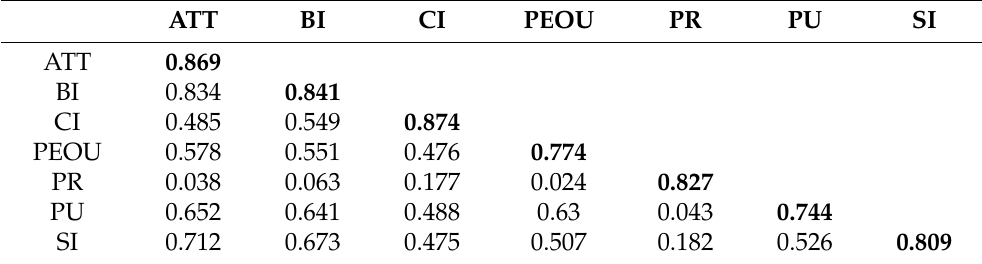
Table 5. Discriminant validity (Fornell–Larcker criterion).